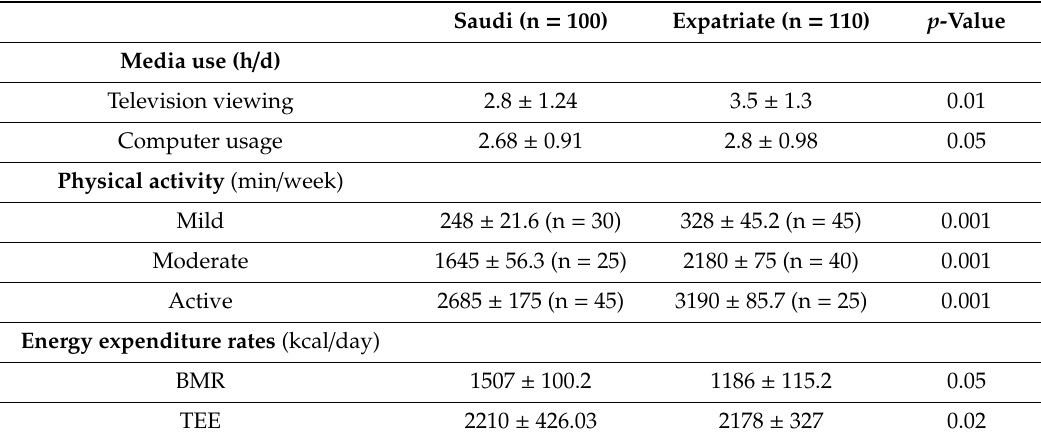
Table 3. Sitting time associated with media use and Physical activity pattern among Saudi and Expatriate girls.